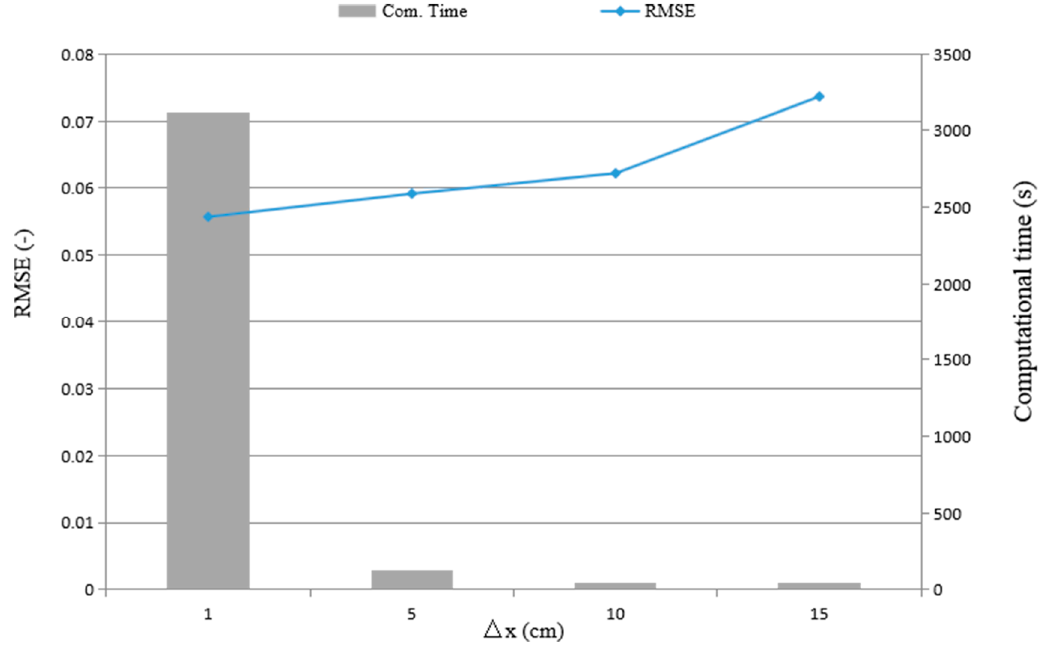
Figure 5. Sensitivity analysis of the numerical simulation using MIKE 3 FM for the different mesh sizes of the experiments in Reference [30].